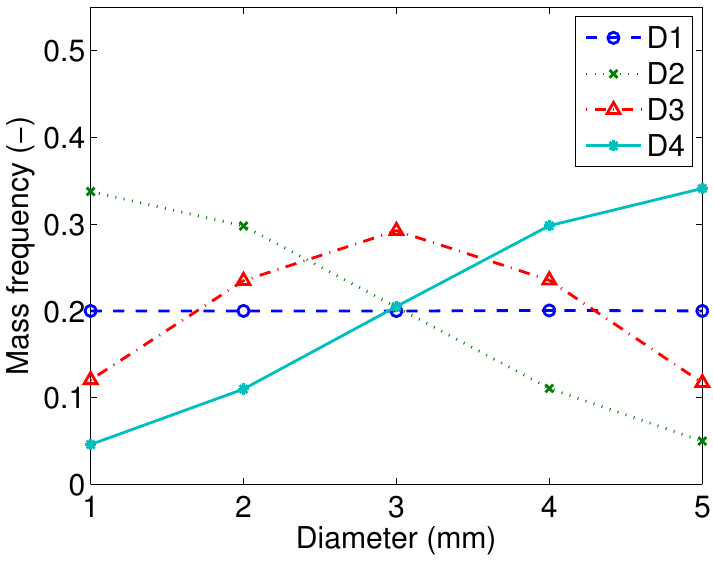
Figure A1. PSD used in DEM simulations to determine collision rates.